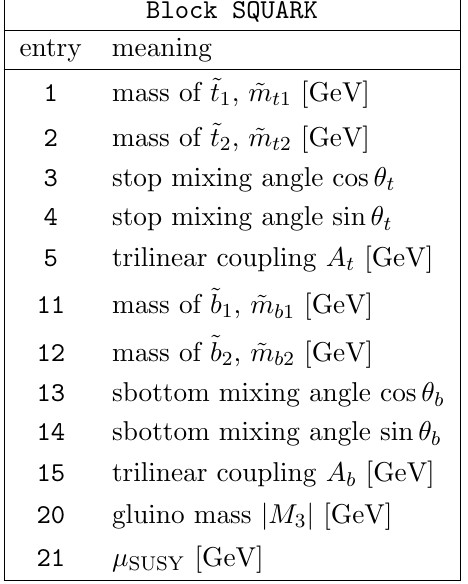
Table 14 . Input parameters of Block SQUARK . For details, see main text.